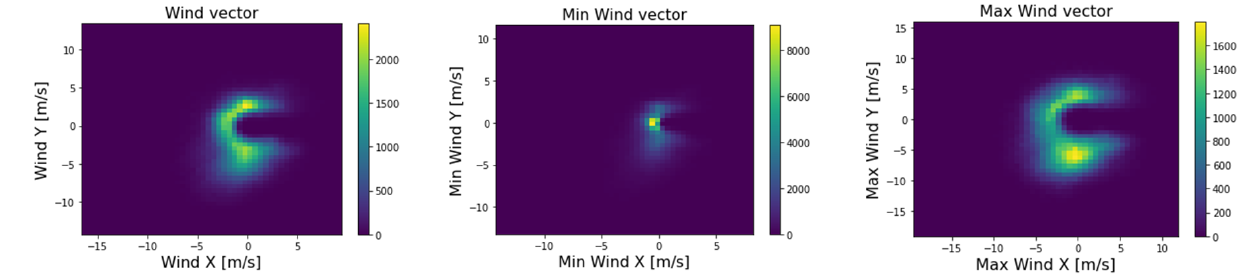
Figure 4. Visualization of the frequency of occurrences of wind characteristics by wind vector.